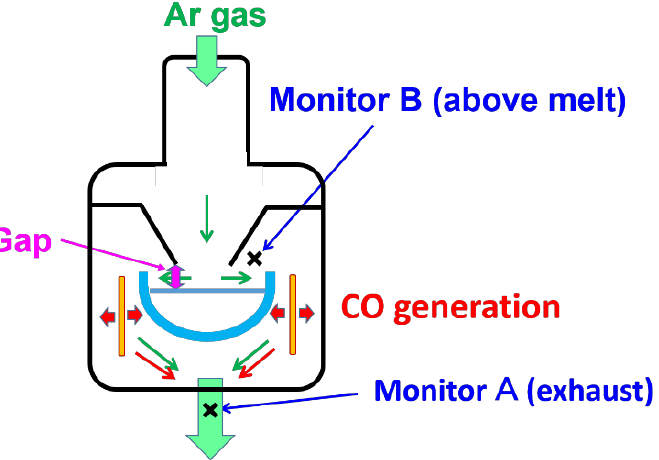
Figure 2. The monitoring locations detecting the CO concentration. The locations, A and B, were near the melt and the exhaust, respectively. Reproduced with permission from Y. Miyamura, H. Harada, X. Liu, S. Nakano, S. Nishizawa, K. Kakimoto, Journal of Crystal Growth; published by Elsevier, 2019, [8].